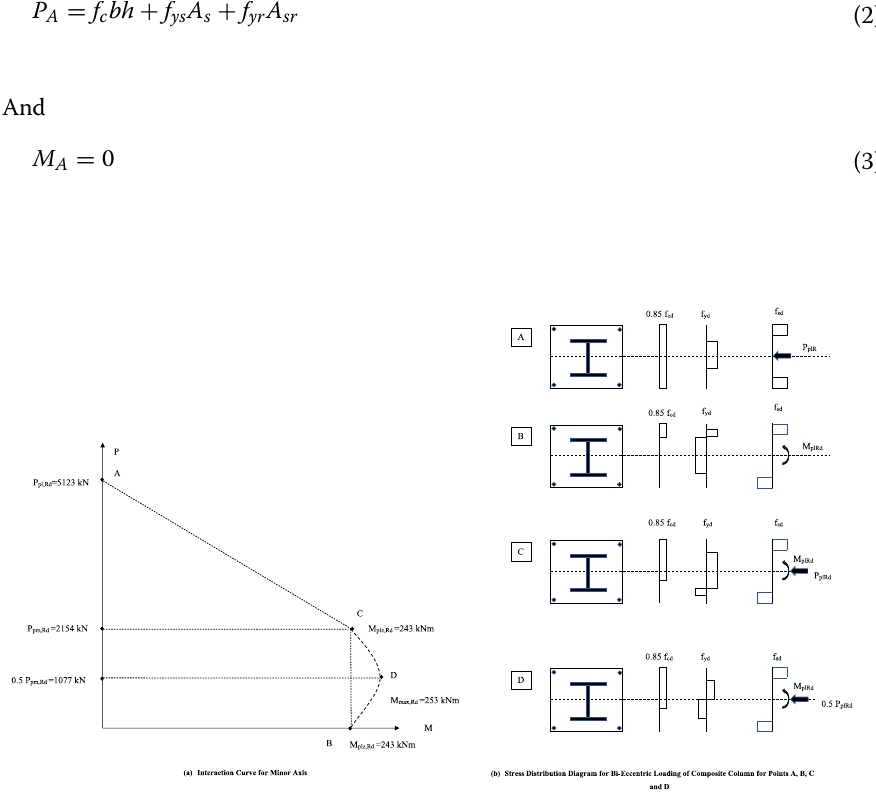
Fig. 9 Load moment interaction curve for major and minor